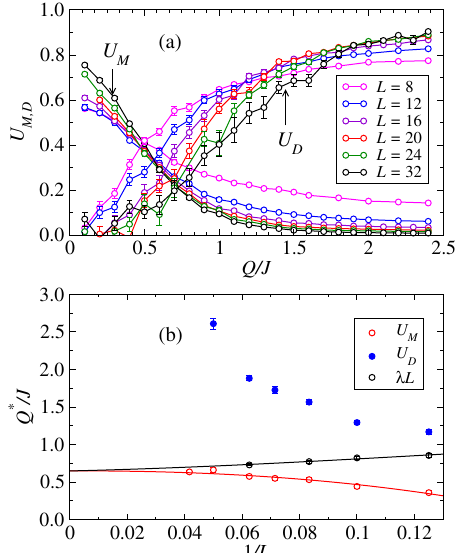
FIG. 15. (a) Binder cumulants vs Q=J for several system sizes of the bimodal random- J model. (b) Crossing points between cumulants for system sizes ð L; 2 L Þ versus 1 =L . Crossing points of the size-normalized spinon string fraction L λ (similar to those shown in Fig. 11) are also shown. Fits (the curves shown) to the latter data set and that for the U crossing points are carried out M using power-law corrections ∝ L − ω (with ω ≈ 1 . 5 and 2.3 for the U and L λ set, respectively), with the constraint of the same M =J ¼ 0 . 65 (cid:2) 0 . 02 , when L → ∞ value of the crossing point, Q c Fig. 9. The ð L; 2 L Þ crossing points are graphed versus the inverse system sizes in Fig. 15(b), along with the crossing points of the scaled string fraction L λ . These two finite-size estimates of the critical point again approach Q from c different directions. Requiring the fits with corrections ∝ L − ω to have the same value of Q =J but allowing for c =J ¼ 0 . 65 (cid:2) 0 . 02 and different values of ω , we obtain Q c the exponents ω ≈ 1 . 5 (for the cumulant crossings) and 2.3